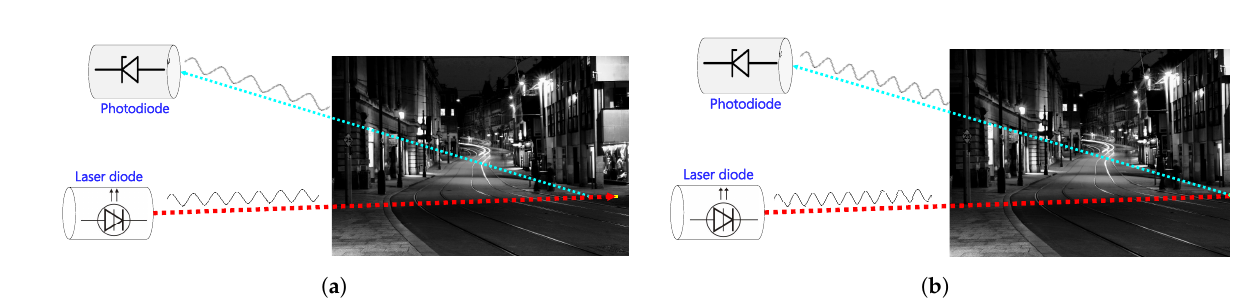
Figure 5. Operating strategy of FMCW LIDAR. ( a ) The LIDAR fires the chirp modulated light at a target and then recovers the modulated frequency of the returned light to estimate range and velocity. ( b ) The LIDAR fires the up chirp modulated light at the target and then recovers the modulated frequency of the returned light. The LIDAR restarts from ( a ) for all